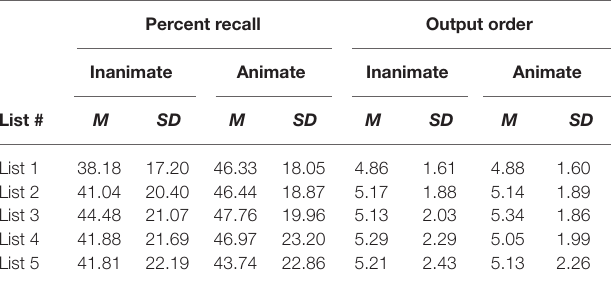
TABLE 1 | Percent recall and output order by animacy and list